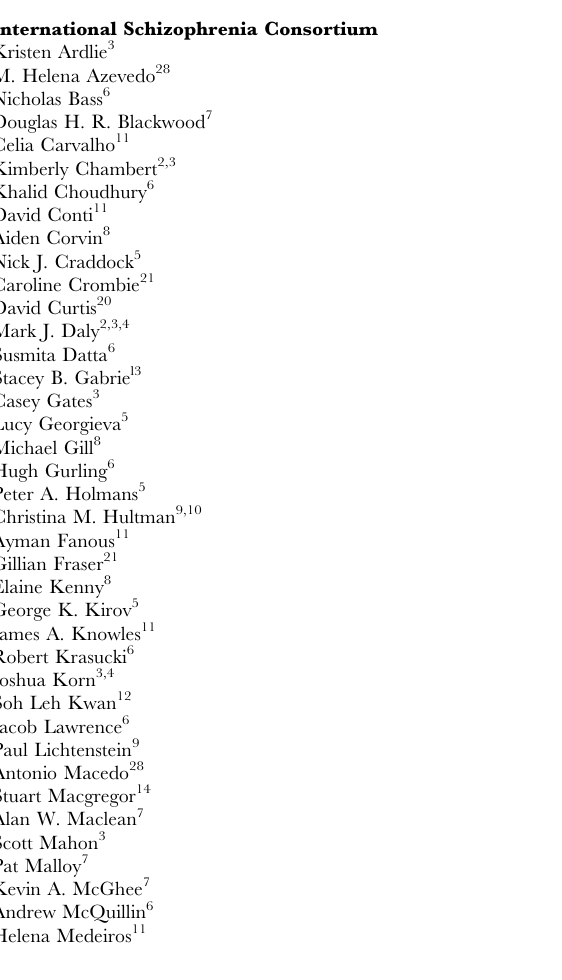
Table S8 Rare or de novo schizophrenia control deletions. Here we list all of the deletions that GRAIL identified as most related to other deleted genes ( p text , 0.05). For each deletion we list the chromosome, the range of the deletion, the GRAIL p-value for the region, and the best candidate gene in the region identified by GRAIL. Most genomic coordinates are listed in HG17. * HG18 coordinates. Found at: doi:10.1371/journal.pgen.1000534.s010 (0.06 MB DOC) Text S1 A. Random SNP groups; B. Comparison of GRAIL to other related